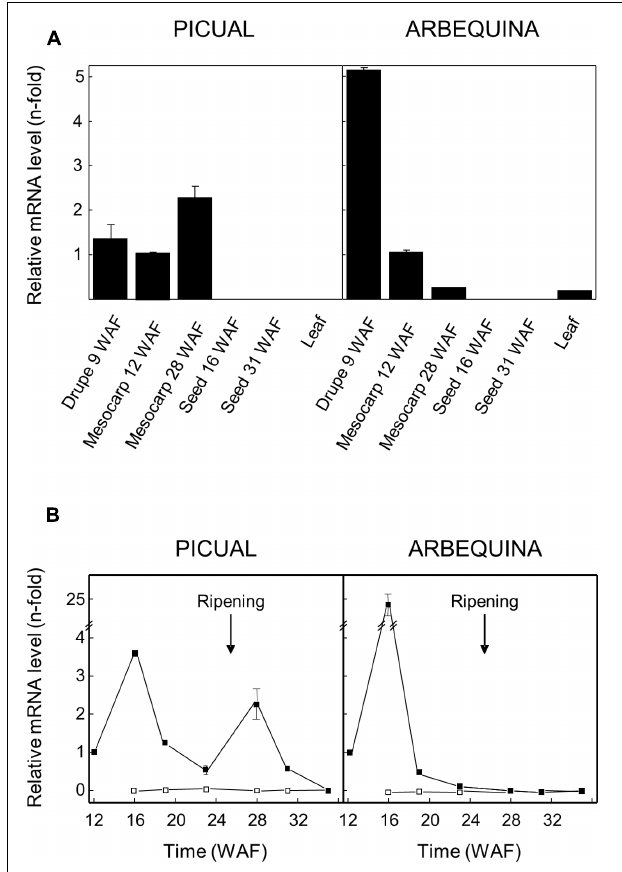
FIGURE 4 | Relative expression levels of olive GLU gene in different tissues of Picual and Arbequina cultivars (A) , and in mesocarp tissue (closed squares) or seeds (open squares) during the development and ripening of olive fruit (B) . The beginning of fruit ripening, which coincides with the appearance of purple color, is indicated by an